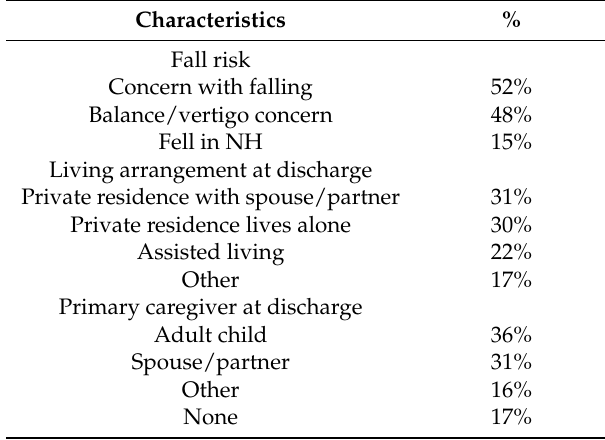
Table 2. Characteristics of transitioned residents at transition from the nursing home (N = 1216